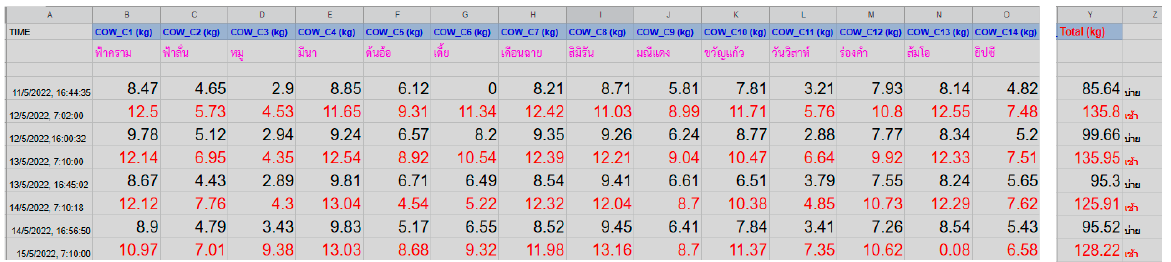
Figure 13. Data recording in Google sheet.